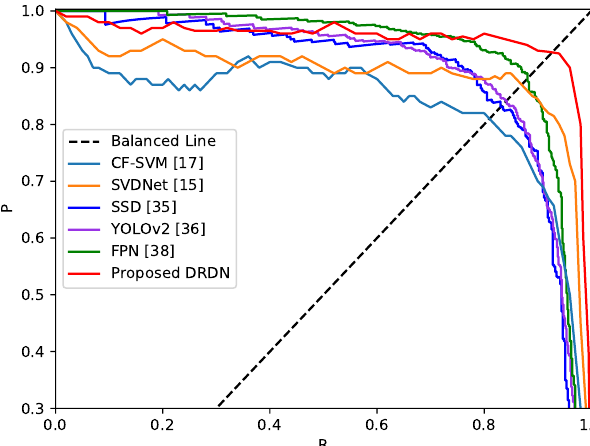
Figure 15. Precision-recall curves of different ship detection methods. CF-SVM, hand-crafted feature; SSD, single shot multi-box detector; FPN, feature pyramid